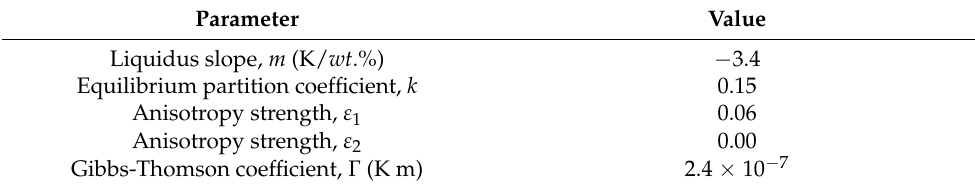
Table 2. The parameters used in the phase field